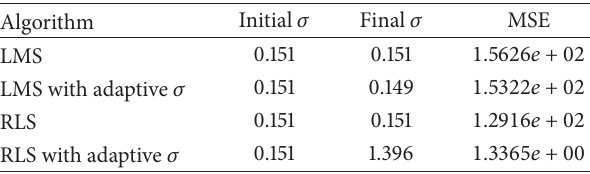
Table 2: Mean square error (MSE) in testing phase.